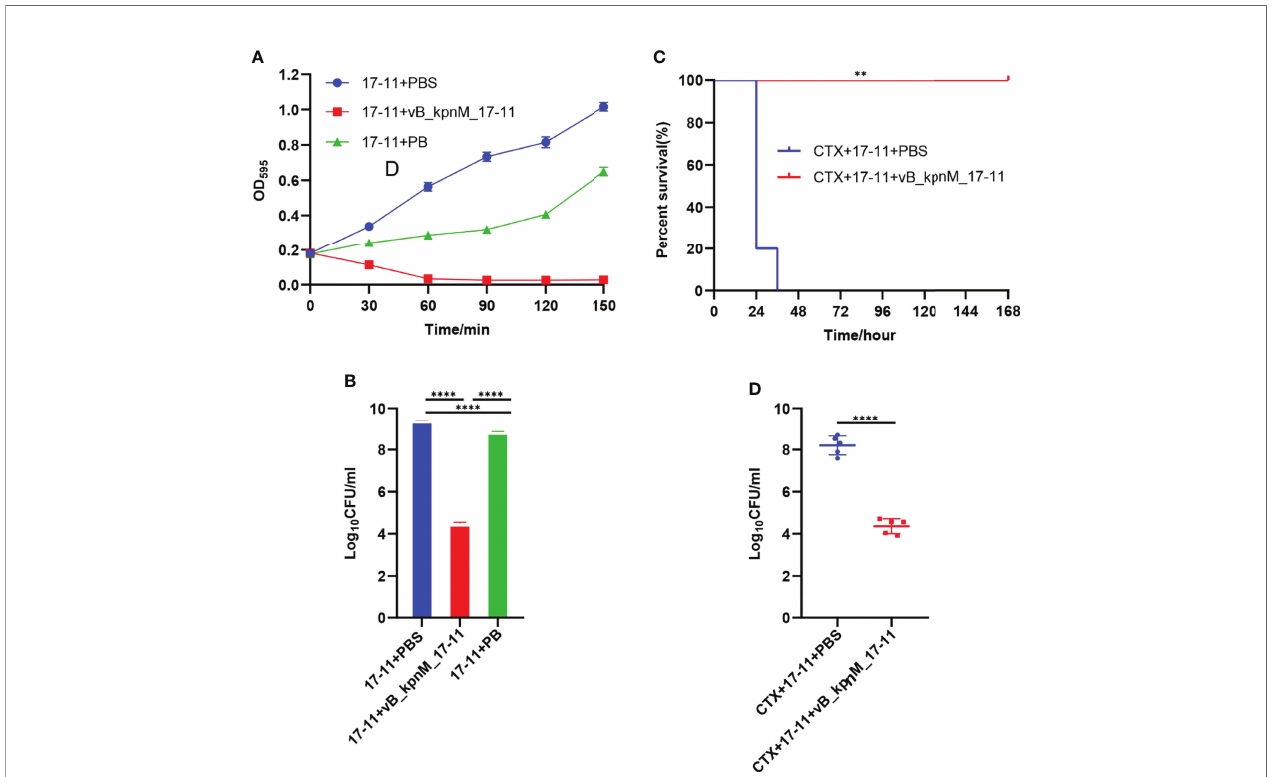
FIGURE 9 | Sterilization experiment in vitro and in vivo . (A) Bacteriostatic curve of phage in vitro . PBS, vB_kpnM_17-11 or PB were added to 50 mL exponential phase K. pneumoniae 17-11. The value of OD 595 was measured every 30 min from 0 min to 180 min. (B) Bactericidal ef fi ciency of phage in vitro . **** P < 0.0001, two-sided Mann – Whitney test. (C) Survival of mice after infection by K. pneumoniae 17-11. ** P < 0.01 (Gehan-Breslow-Wilcoxon test). (D) Abdominal lavage fl uid bacterial load. Mice were infected with K. pneumoniae 17-11 intraperitoneally and treated with phage. Peritoneal lavage was harvested at 24 h post infection and CFU were quanti fi ed. **** P < 0.0001, two-sided Mann – Whitney